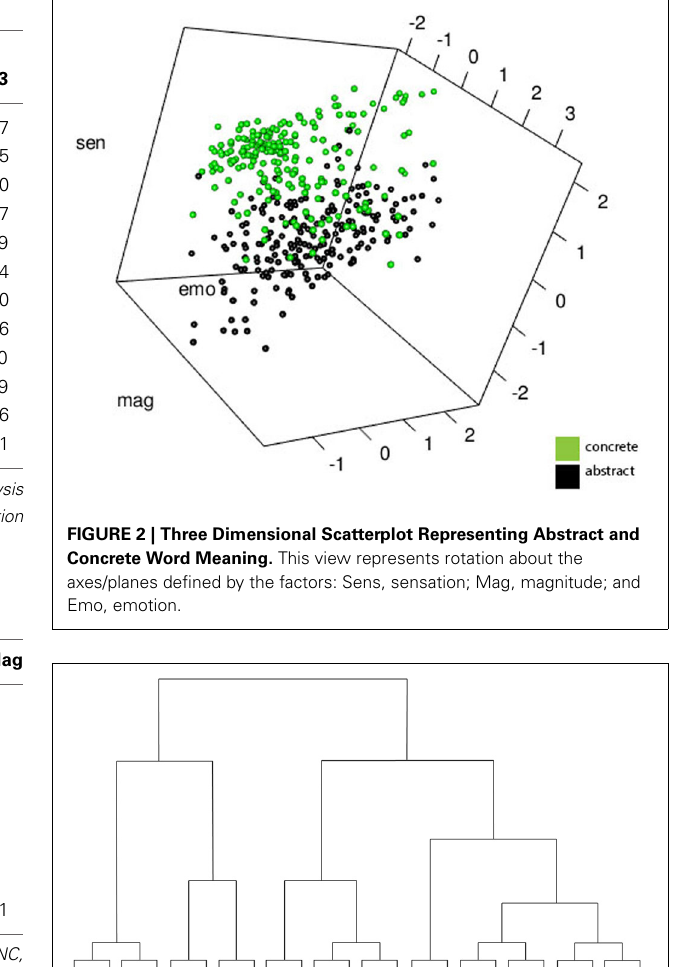
Table 4 | Factor analysis/component matrix for dimensions.